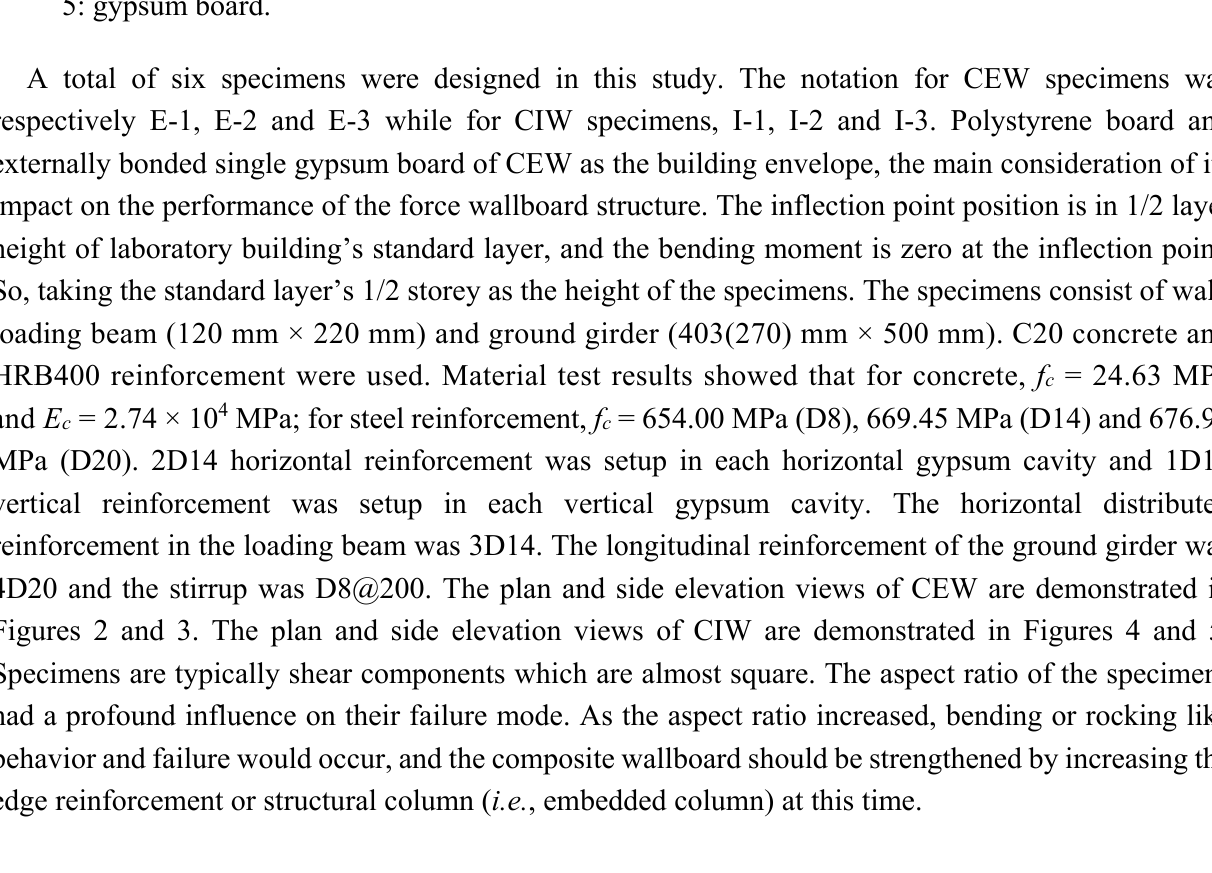
Figure 1. Schematic diagram of CEW multi-cavity gypsum board. 1: vertical gypsum cavity; 2: insulation board; 3: horizontal gypsum cavity; 4: externally bonded single gypsum board; 5: gypsum